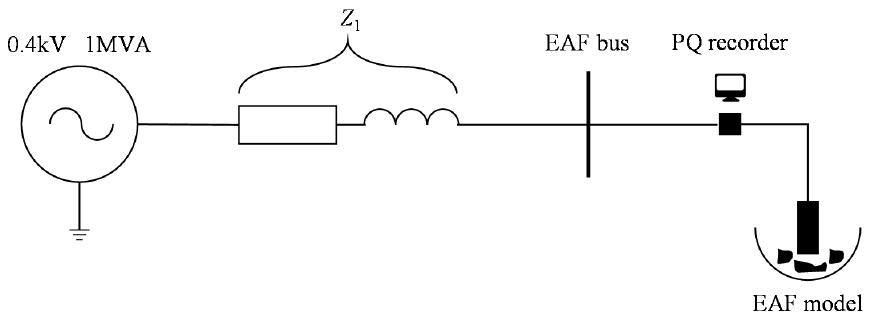
Figure 7. Simplified circuit diagram for data measurement of the electric arc furnace (EAF).